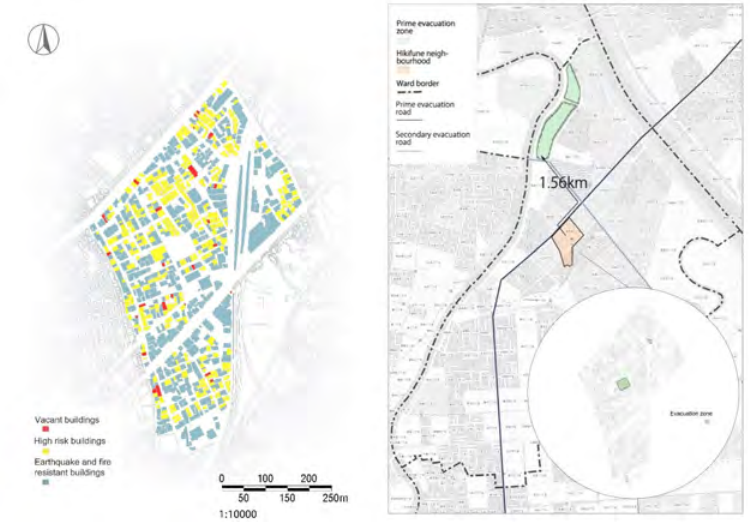
Figure 5. (a) High-risk buildings plan. (b) Evacuation zones